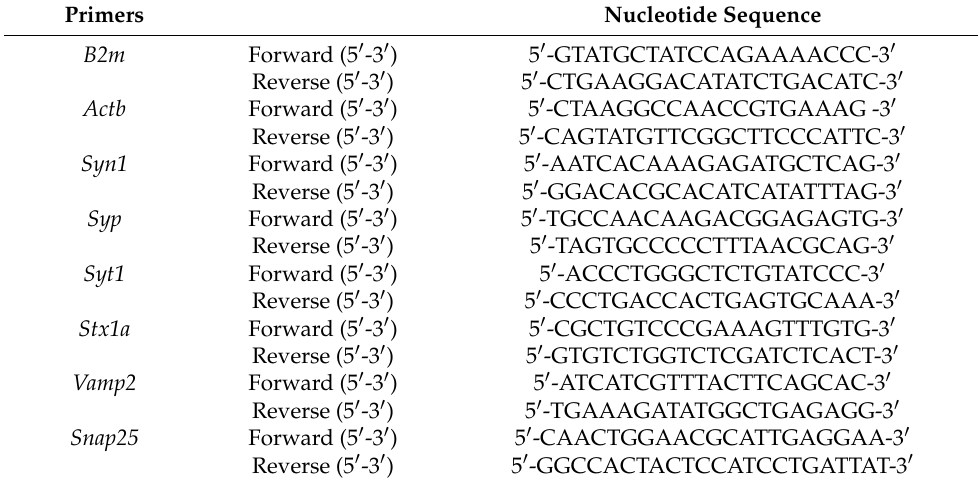
Table 1. Primers used for